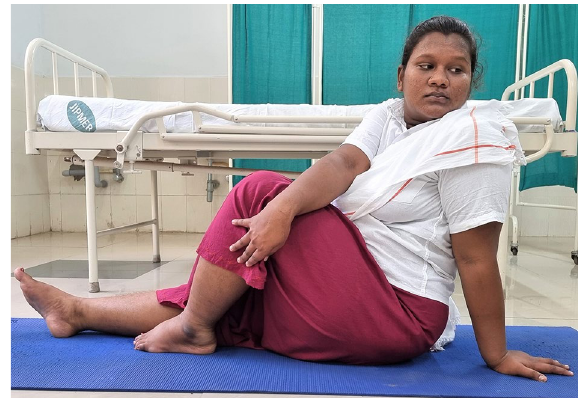
Figure 7. Vakrasana.